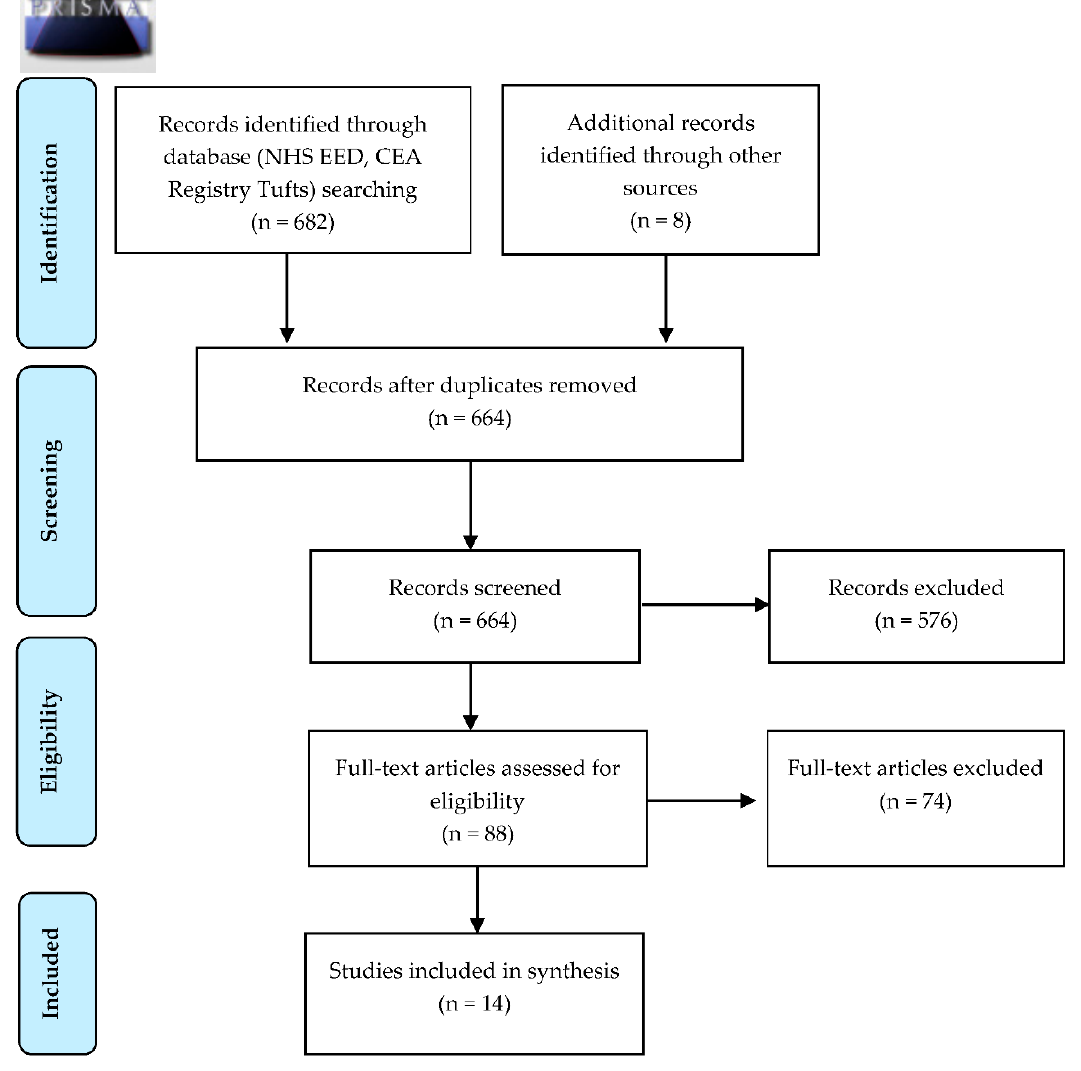
Figure 2. PRISMA diagram for the resource use, costs, and cost-effectiveness for hepatitis C screening.